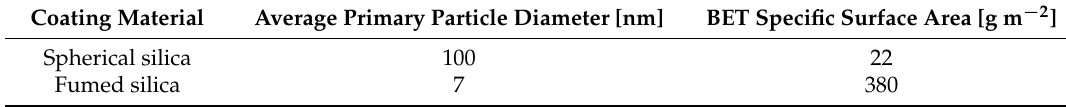
Table 1. Characteristics of silica particles used as coating materials in this